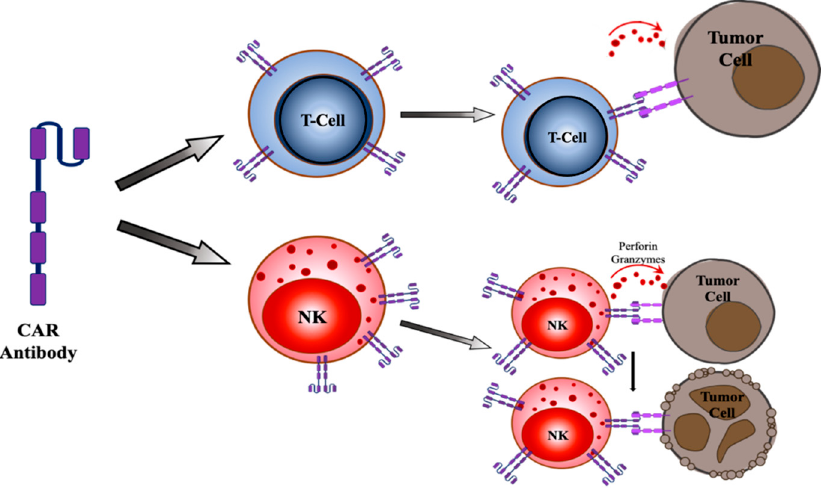
Figure 3. Targeting of tumor cells by T cells and NK cells. T cells and Natural Killer (NK) cells expressing a chimeric antigen receptor (CAR) recognize the antigens present on the tumor cells, bind them and release perforin and granzymes to directly initiate tumor cell death.